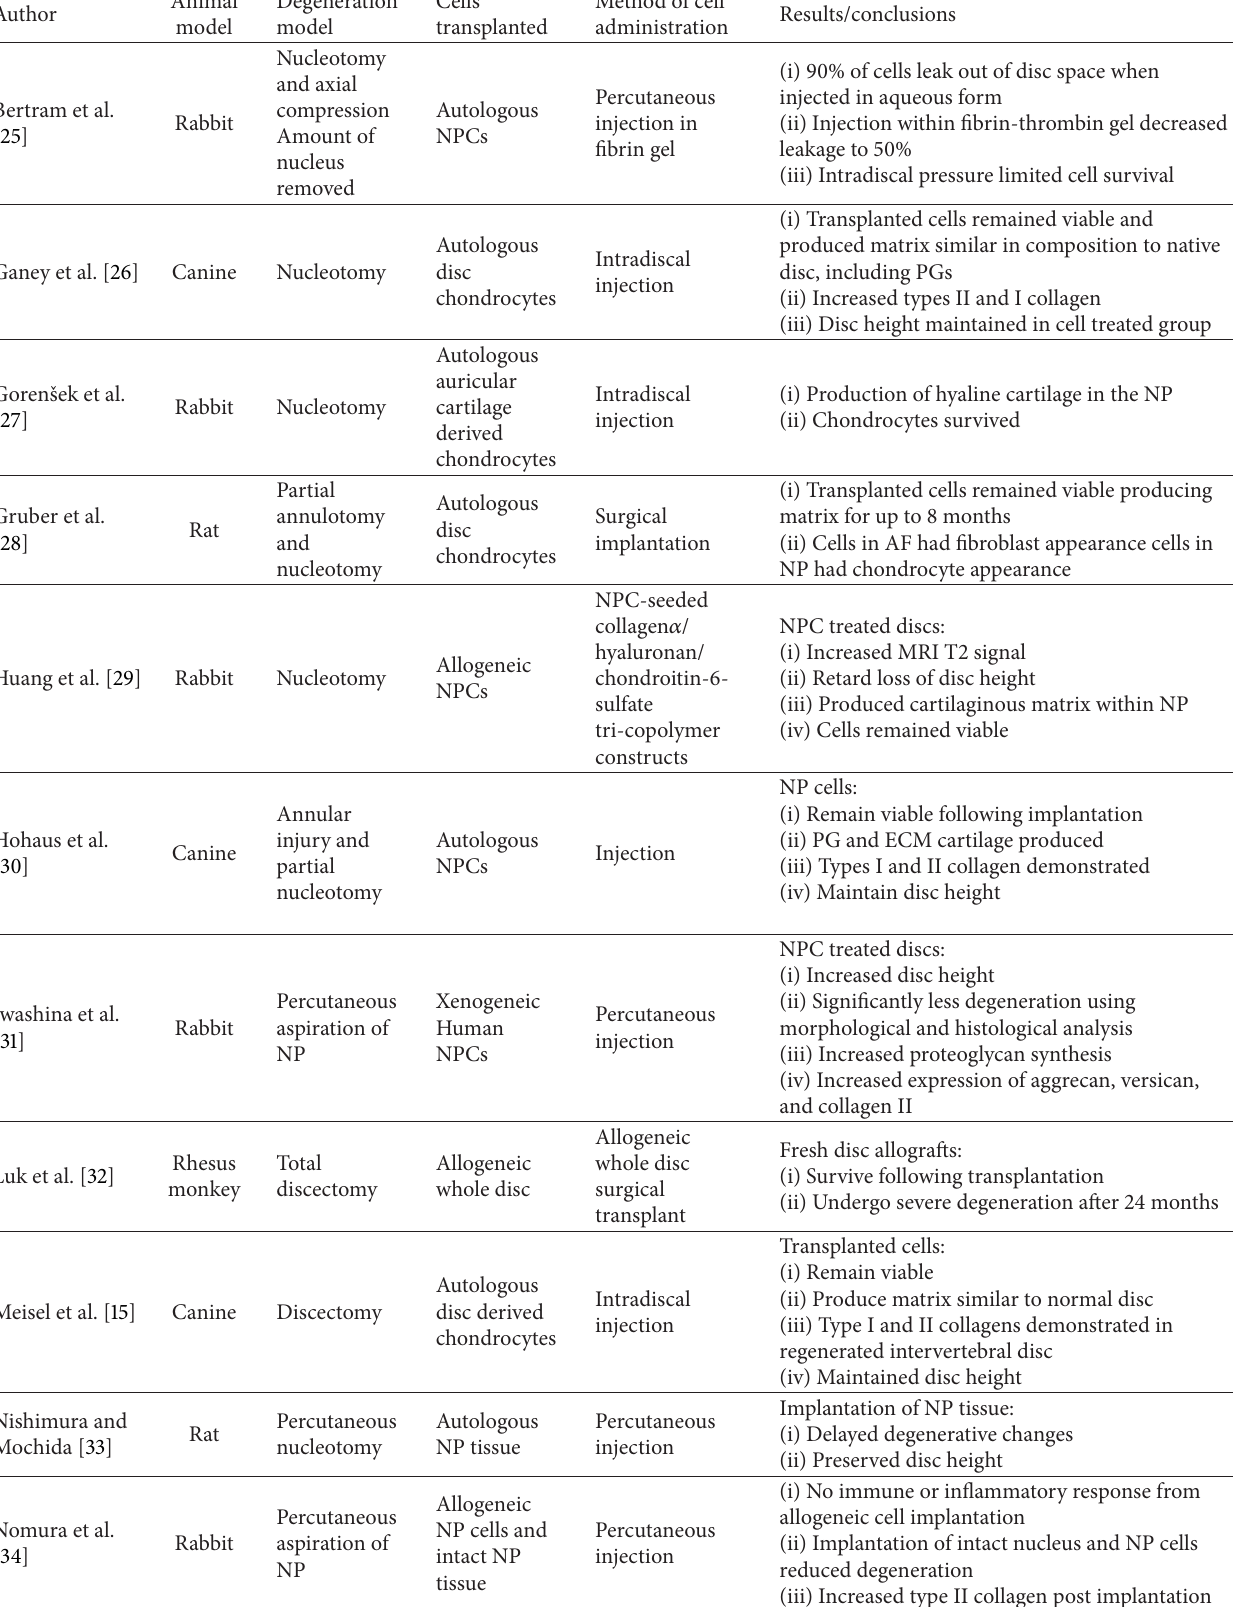
Table 1: Studies assessing the ability of disc derived and non-disc derived chondrocytes to regenerate lumbar intervertebral discs.